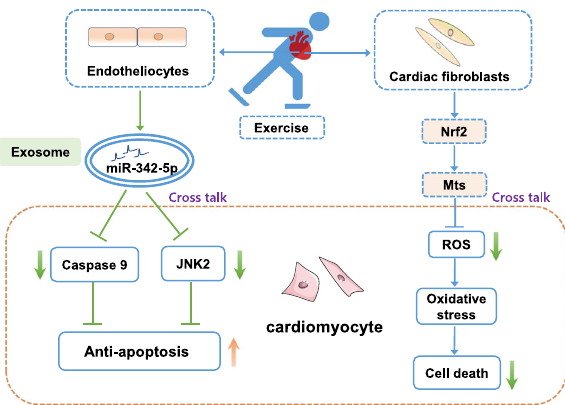
Fig. 5 Crosstalk between noncardiomyocyte and cardiomyocytes in exercise-induced cardiac protection. Exercise promotes the expression of exosomal-nuclear factor-erythroid 2 related factor 2 (Nrf2)/metallothioneins (Mts) in cardiac fi broblasts, inhibiting cardiomyocyte reactive oxidative species (ROS) production and cell apoptosis. Endotheliocytes produce EVs (containing miR-342-5p) and deliver to cardiomyocyte, leading to an increase in the antiapoptosis capacity via inhibiting caspase 9 as well as c-Jun N- terminal kinase